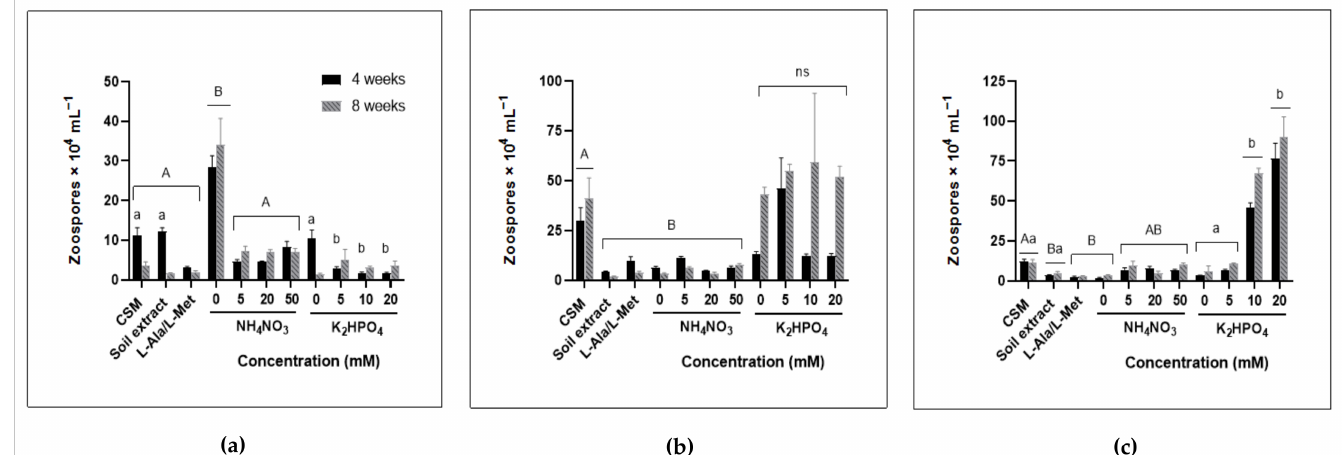
Figure 3. Zoospore haemocytometer quantification at 4 and 8 weeks. ( a ) G. semiglobifer. Signif- icant differences were found between treatments in the nitrogen series (F 6, 69 = 39.32, p < 0.05) and phosphate series (F 5, 59 = 5.465, p < 0.05) ( b ) Spizellomyces sp. Significance was found in the nitrogen series (F 6, 68 = 22.11, p < 0.05), but not the phosphate series (ns) (F 5, 56 = 3.371, p > 0.05) ( c ) R. rosea . Significance was found in both the nitrogen (F 6, 70 = 15.94, p < 0.05) and phosphate series (F 5, 60 = 96.17, p < 0.05). Error bars are SEM. Significant difference in the nitrogen series are identified with capital letters (A, B) and lower-case letters (a, b) indicate significance between the phosphate